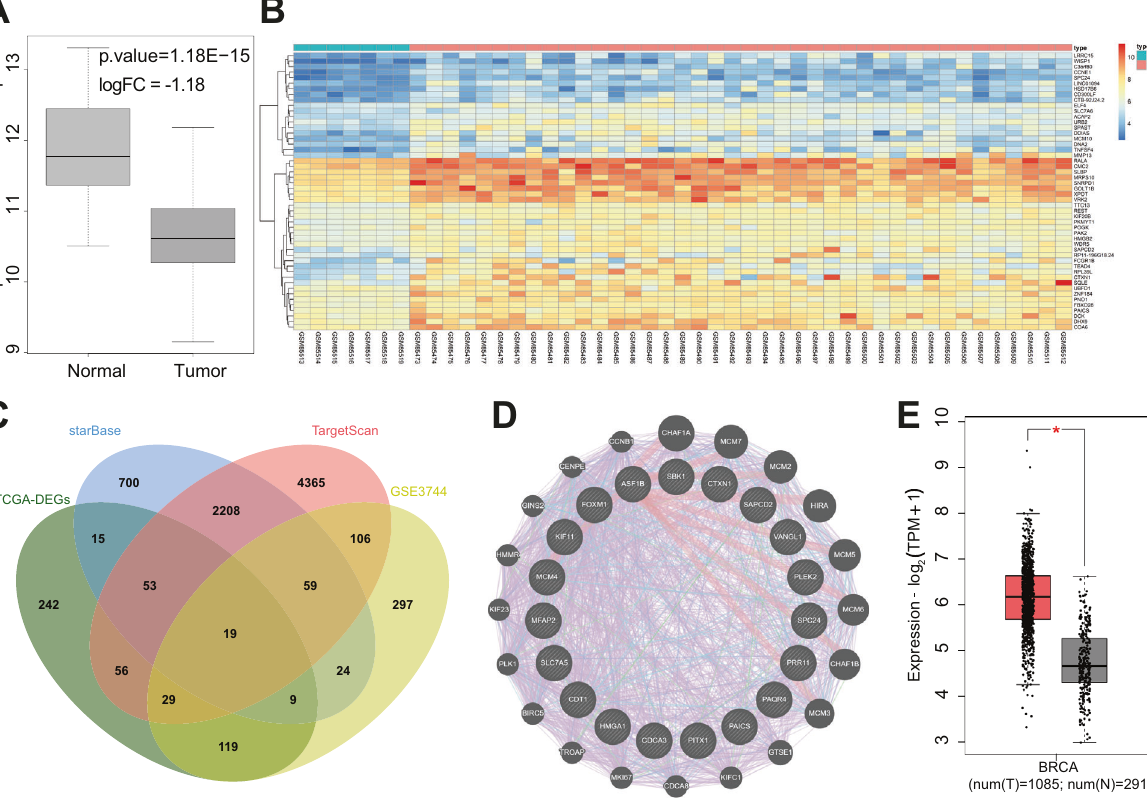
Fig. 1 Analysis of miR-4731-5p expression in microarray data set and prediction of downstream regulatory target genes. A The differential expression of miR-4731-5p in GSE57897, the x axis represents the sample type, the y axis represents the expression value, the left box plot represents normal samples, the right box plot represents tumor samples, and the upper right is the differential p value. B Heat maps of the top 50 signi fi cantly upregulated gene (arranged in positive sequence based on an adjusted p value) in GSE3744 data set including seven normal samples and 40 tumor samples. The x axis represents the sample number, the y axis represents the gene name, and the tree diagram on the left represents the gene expression level clustering (adjusted p value). Each small square in the fi gure represents the expression of a differential gene in a sample, the histogram on the upper right is the color scale. C Prediction of downstream target genes of miR-4731-5p. The four ellipses in the fi gure are the signi fi cantly high expression genes in breast cancer retrieved by TCGA, the target genes predicted by starBase and TargetScan databases, and the signi fi cantly high expression genes in the GSE3744. The central part is the intersection of four sets of data. D Interaction analysis of candidate target genes, the middle part of the fi gure represents 19 candidate genes, the outer circle represents 20 genes that are related to the candidate gene, and the line between the circles indicates that there is an association between genes. E The differential expression of PAICS genes in breast cancer and normal samples included in TCGA and GTEx. The x axis indicates the sample type, the y axis indicates the expression value, the red box plot indicates the tumor sample, and the gray box plot indicates the normal sample. * p < RESULTS miR-4731-5p and PAICS are predicted to be involved in breast cancer Initial analyses of the GSE57897 microarray data set indicated a reduction in miR-4731-5p expression in breast cancer samples (Fig. 1A), however, there is no relevant research in regard to the role of miR-4731-5p in breast cancer. In order to further elucidate the mechanism of miR-4731-5p in breast cancer, the target genes of miR-4731-5p were predicted using the starBase and TargetScan databases. Additionally, the signi fi cantly highly expressed genes in TCGA breast cancer were retrieved from the GEPIA2 database. In addition, 662 signi fi cantly highly expressed genes were obtained from the microarray data set GSE3744 (Fig. 1B). Subsequently, the predicted target genes from starBase and TargetScan, highly expressed genes in TCGA, and highly expressed genes from the GSE3744 data set were intersected, obtaining a total of 19 intersected genes (Fig. 1C). Further interaction analyses of these 19 genes were carried out, and their related genes were ampli fi ed at the same time to obtain the interaction score, with PAICS exhibiting the highest score in the interaction network (Fig. 1D and Supplementary Table 2).